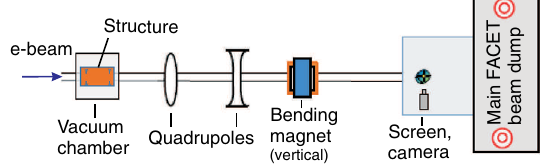
FIG. 2. Plot of the electric field (a) and magnetic field (b) of the fundamental mode over one quarter of the period of the regular cell (gap ¼ 0 . 2 mm), at synchronous frequency. These fields are calculated for a bunch charge of 3.2 nC and 50 μ m long in an infinite traveling wave